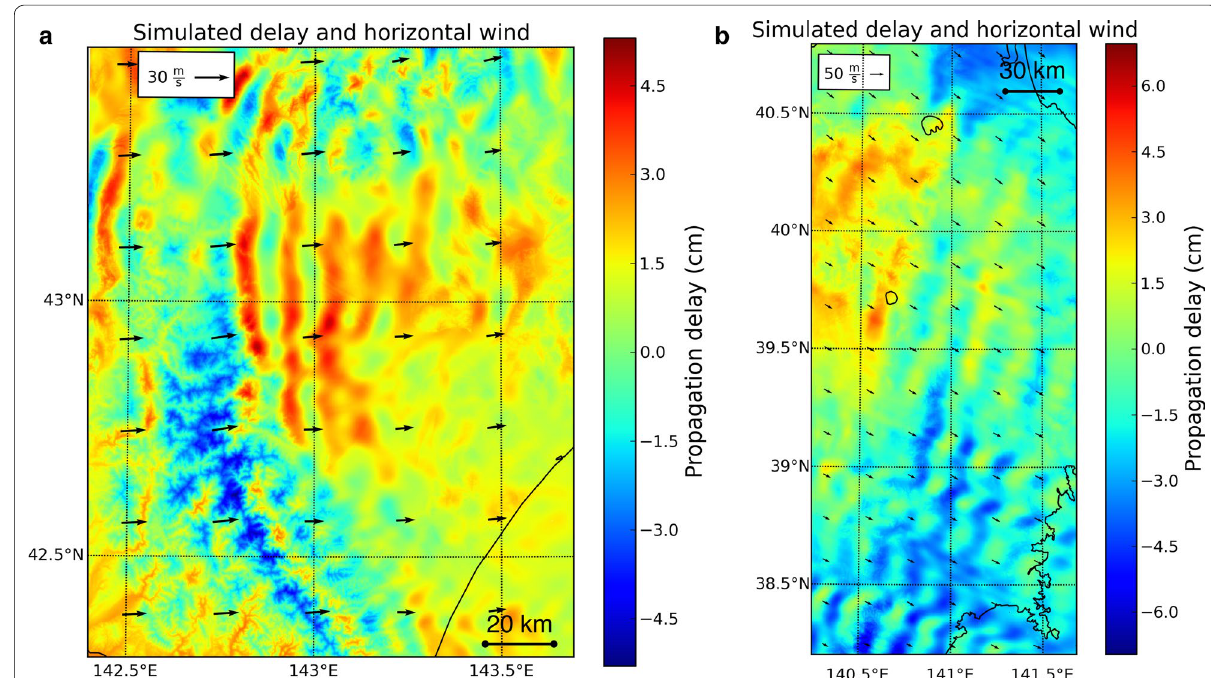
Fig. 7 Simulated propagation delay maps by WRF. Simulated propagation delay maps with horizontal wind vectors at 4000 m a.s.l. a 02:30 UTC on September 6, 2014, and b 02:30 UTC on April 30,